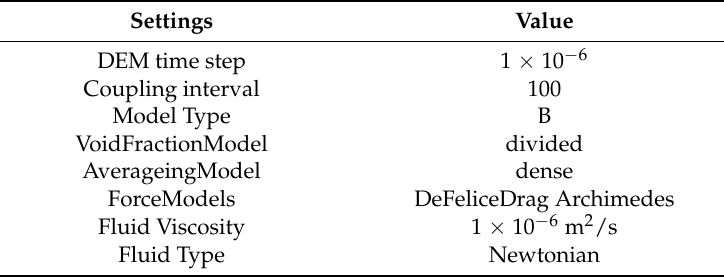
Table 1. Some key CFD–DEM settings.